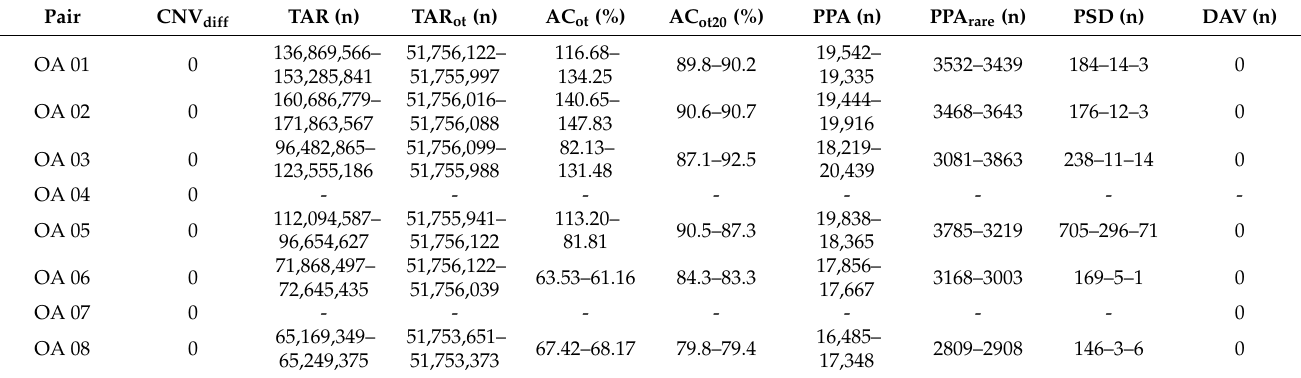
Table 3. Determination of the exonic sequence differences in discordant monozygotic twins. All DNA was extracted from blood. CNVdiff; differences in Copy Number Variation size or presence between twin pairs, TAR; total of aligning reads, TARot; total aligning reads on target, ACot; average coverage on target, ACot20; percentage of target covered at least 20X, PPA; predicted protein altering including variants affecting splicing, PPArare,; rare (MAF < 0.001) protein altering, PSD; putative sequence differences, sequence differences depicted using (1) GATK unified genotyper, (2) negative binomial statistics, and (3) Fisher exact test and repeat filter. DAV; differences after validation with Sanger sequencing. Counts and percentages depicted as twin sibling affected and twin sibling not